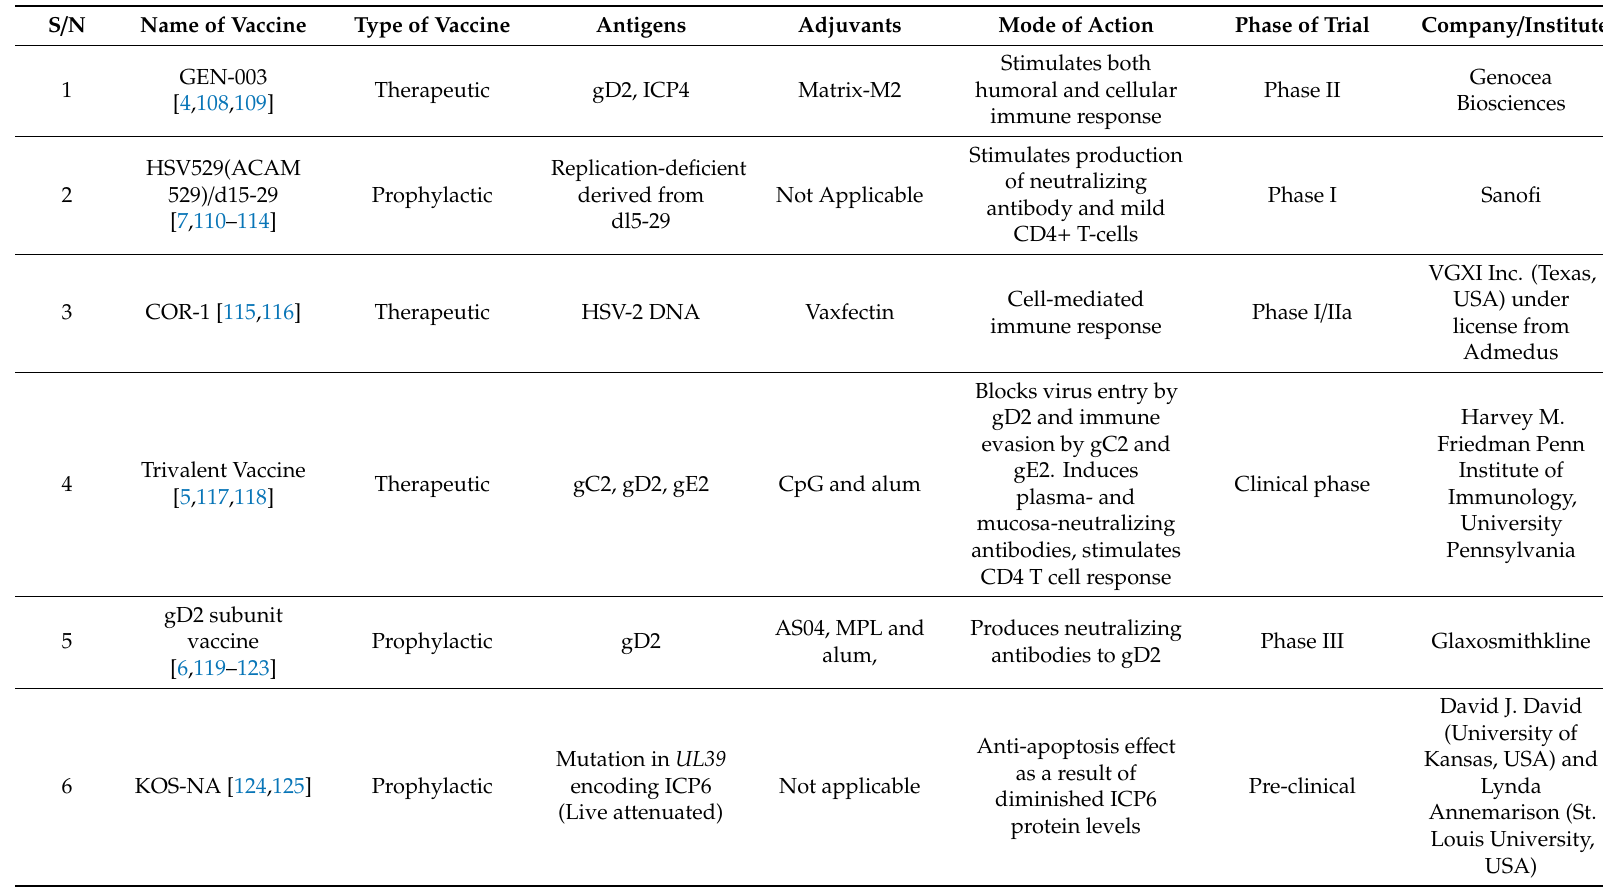
Table 1. Types of vaccines that have been developed against herpes simplex